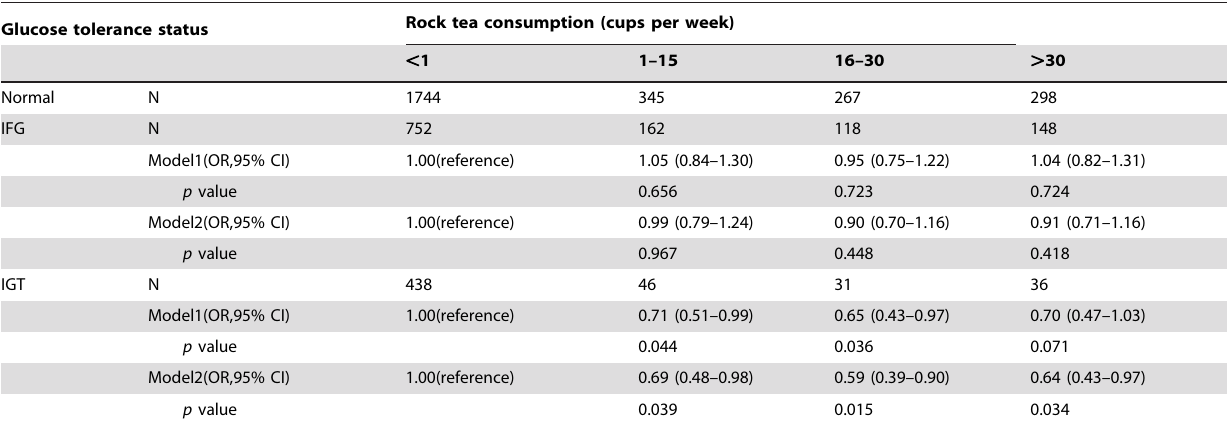
Abbreviations: CI, confidence interval; IFG, impaired fasting glucose; IGT, impaired glucose tolerance. Model1: Adjusted for age, gender, and level of rock tea consumption. Model2: Adjusted for age, gender, level of rock tea consumption, dyslipidemia, family history of diabetes, consumption of milk, consumption of soybean milk, smoking status, consumption of alcohol, physical activity, sleep status, BMI, and waist to hip